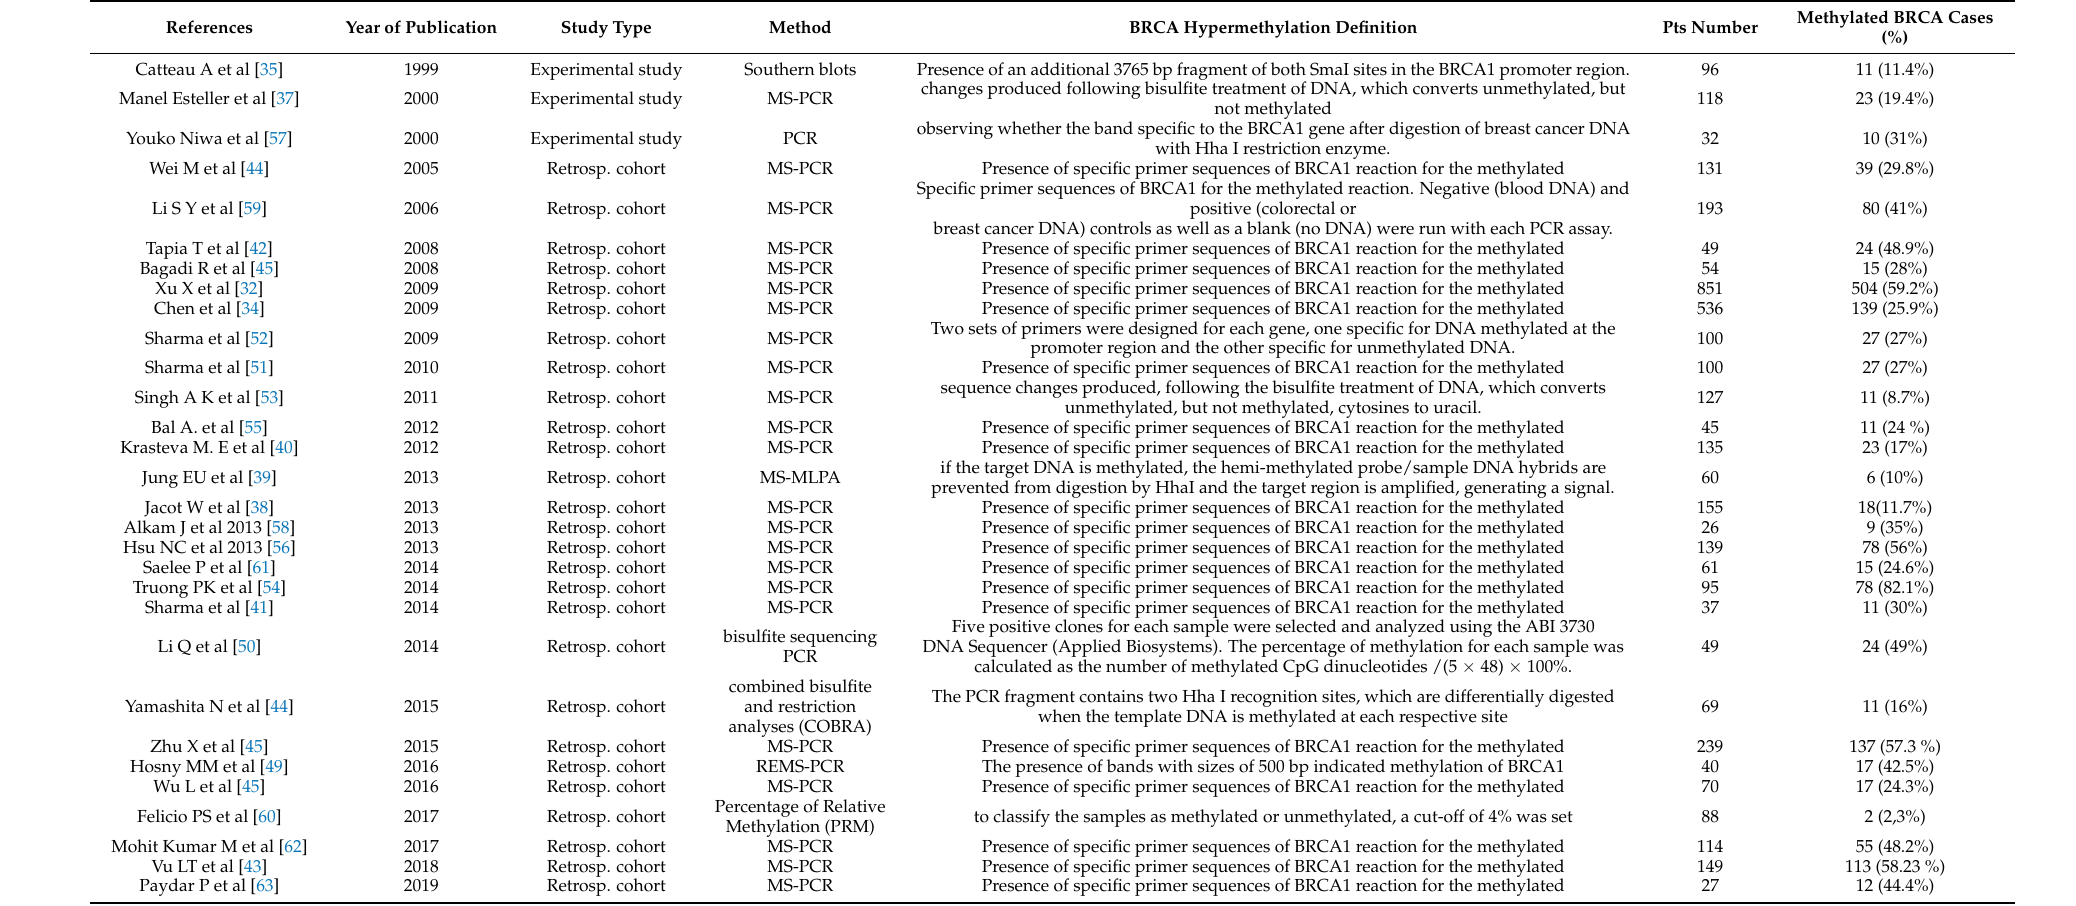
Table 1. Characteristics of the included